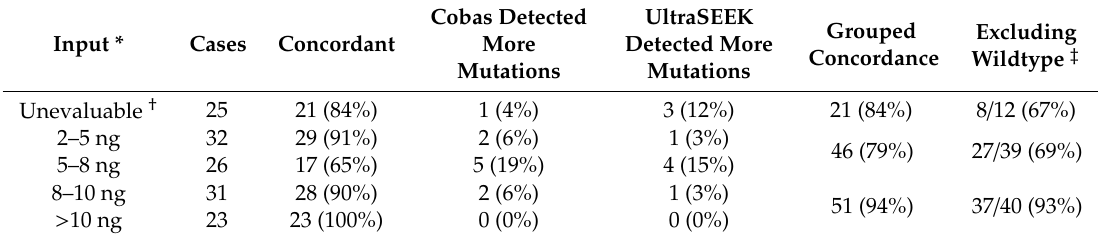
Table 3. Concordance of mutation detection between UltraSEEK ™ and Cobas ® according to ccfDNA input